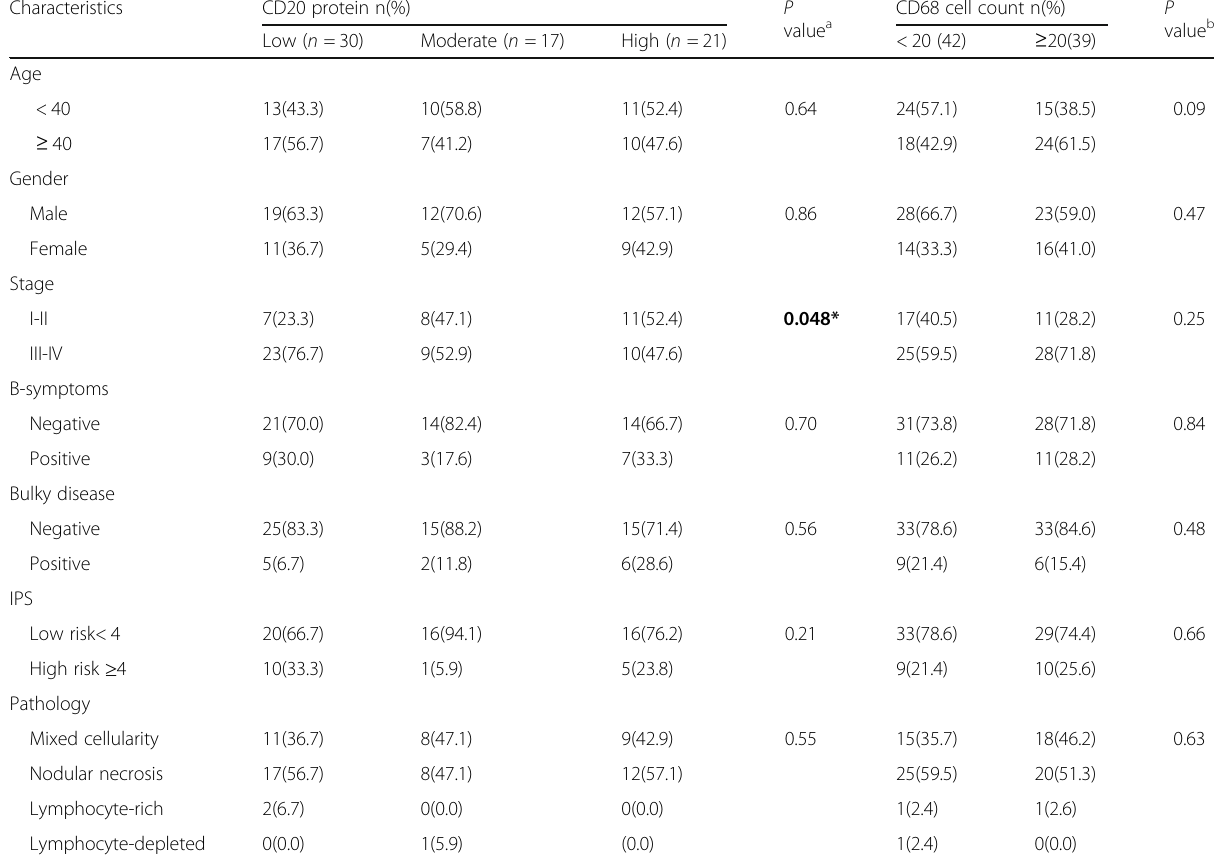
Table 3 Association between CD68+ cell count, CD20 expression and patients ’ cinico-pathological features